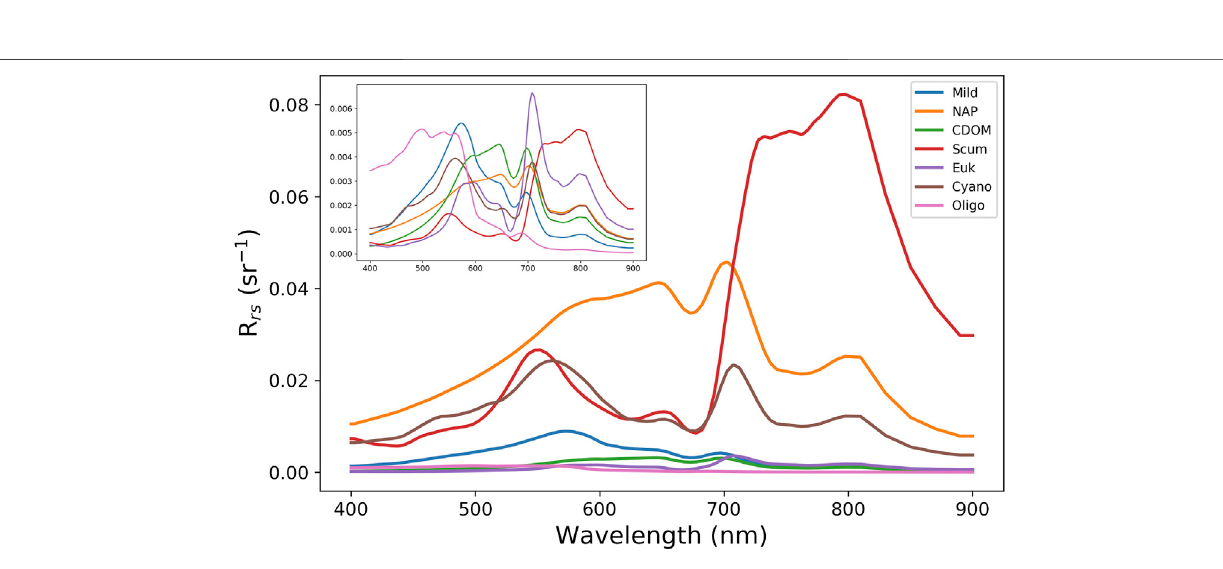
FIGURE3| MedianR rs spectraofthesevenmanuallyde fi nedOWTsderivedfromthesetof13clusters.Theinsetshowsthesamespectraonastandardizedscale, achieved by removing the mean and scaling to unit variance in order to better show shape